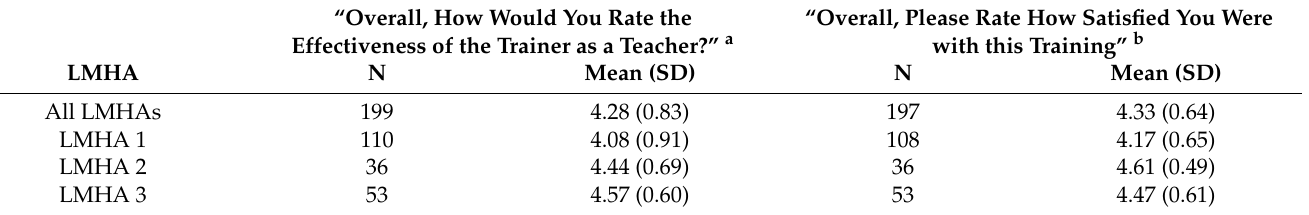
Table 5. Local Mental Health Authority Employee Attendee Assessments of Champion-delivered Trainings.